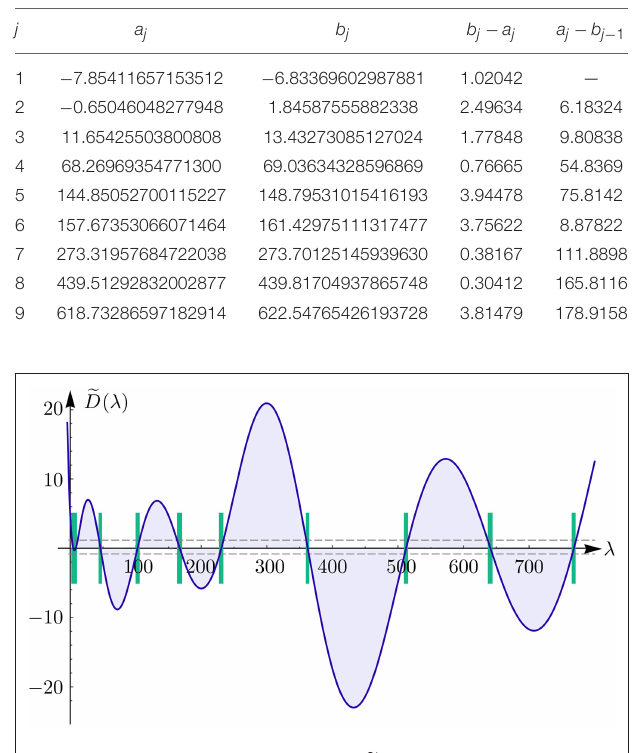
D (λ) from Example e